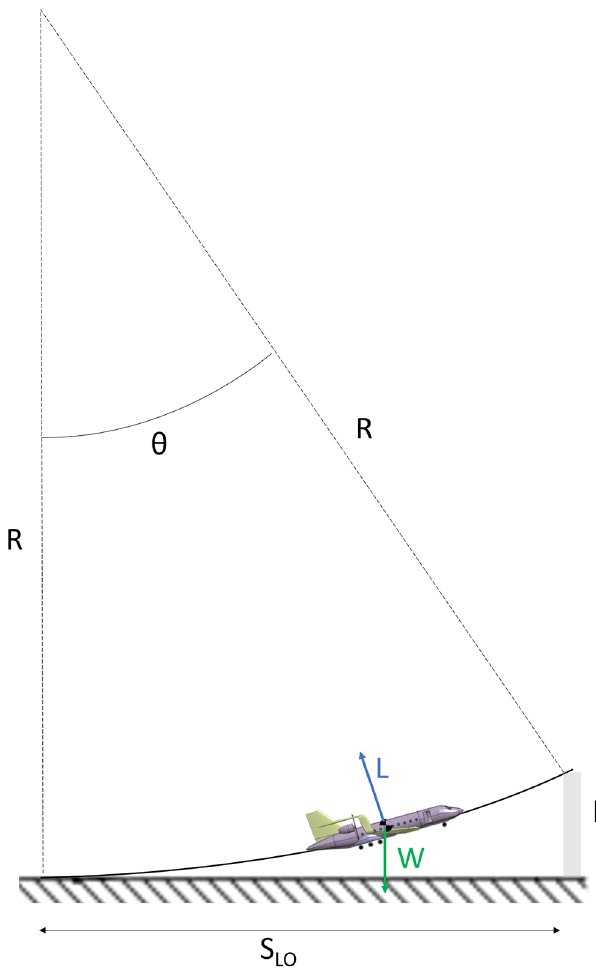
Fig. 16. Circular trajectory in the lift-off